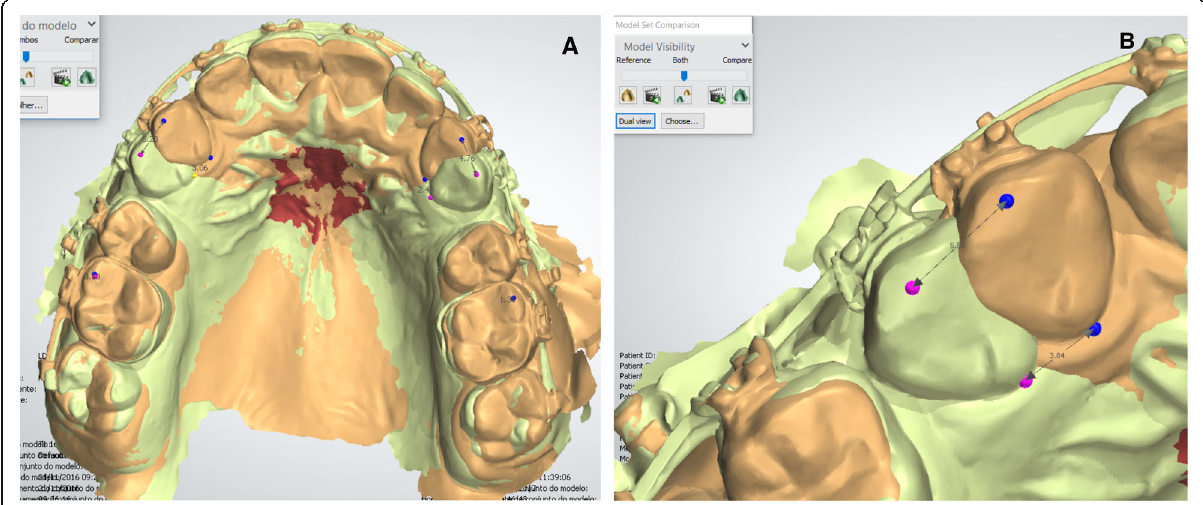
Fig. 3 Superimposed digital models. In brown, the baseline model and in green a comparison model. A Occlusal view illustrating superimposition on palatal rugae. B Incisal and cervical measurement performed on the canines